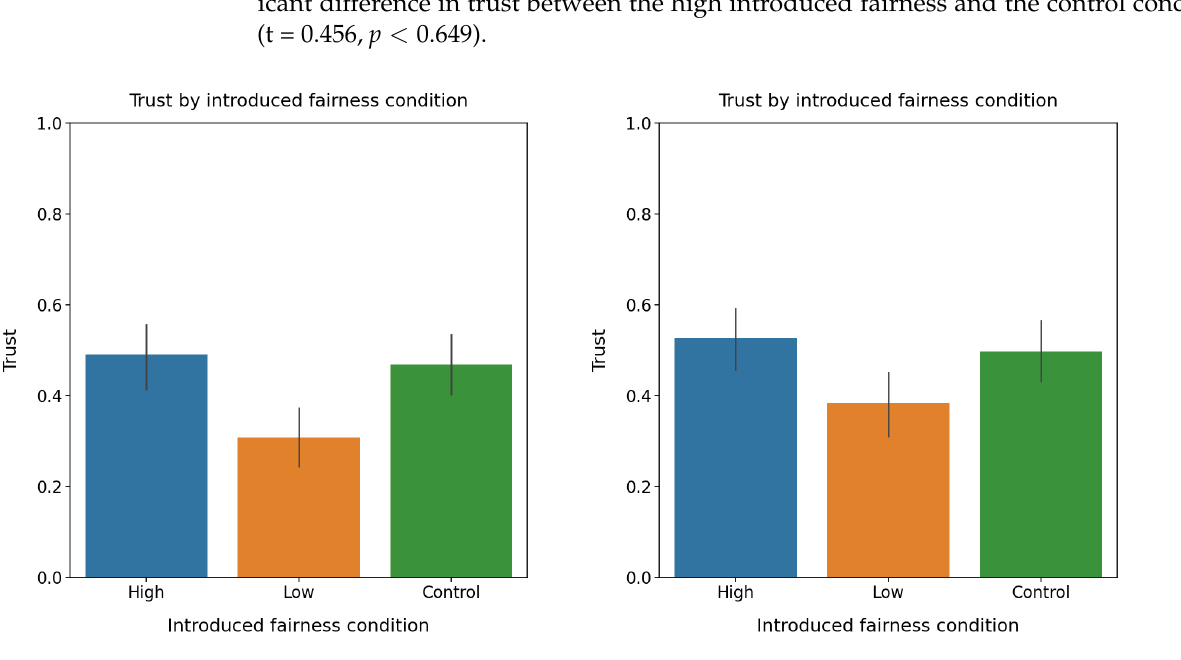
Figure 4. Effects of fairness on user trust under different explanations. ( a ) effects of fairness on user trust under the example-based explanation; ( b ) effects of fairness on user trust under feature importance-based